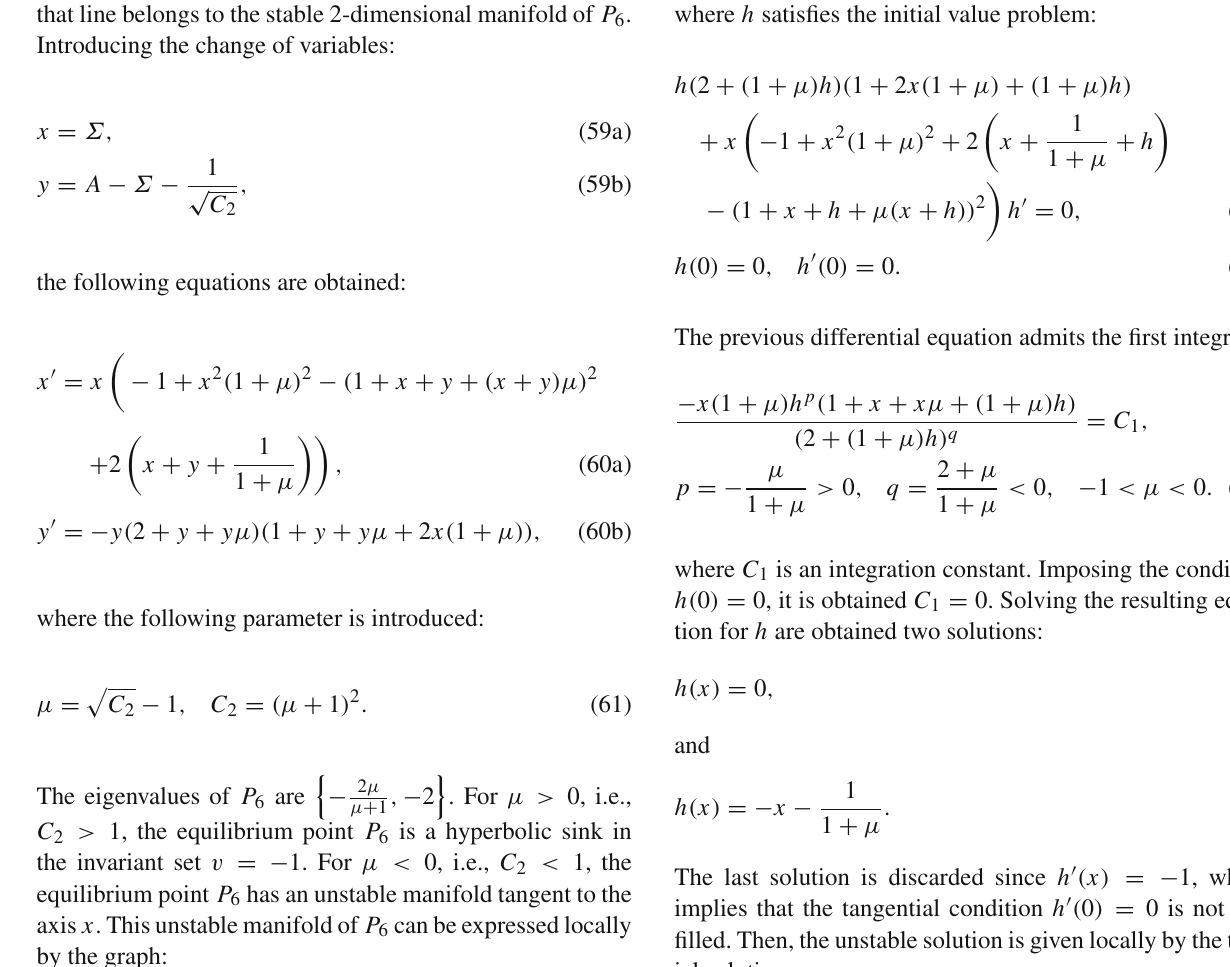
that line belongs to the stable 2-dimensional manifold of P 6